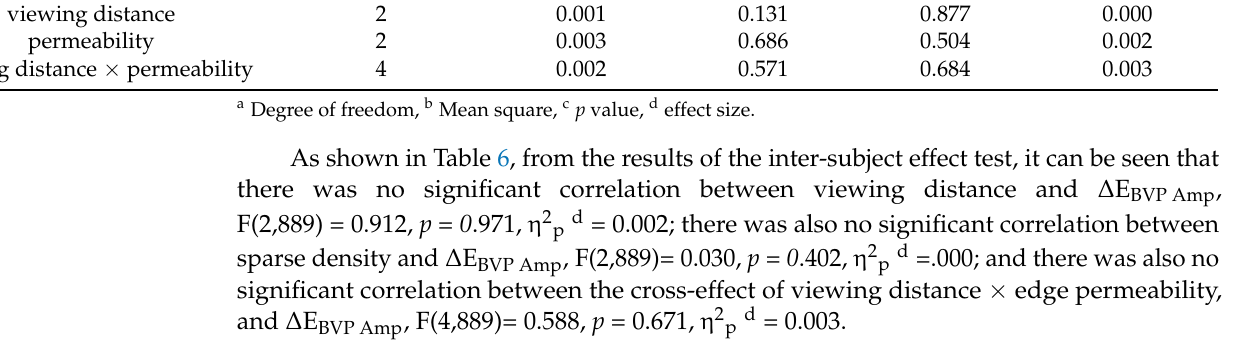
Table 6. Impacts of different viewing distances and permeability levels on (cid:52) E BVP Amp. df a MS b F p